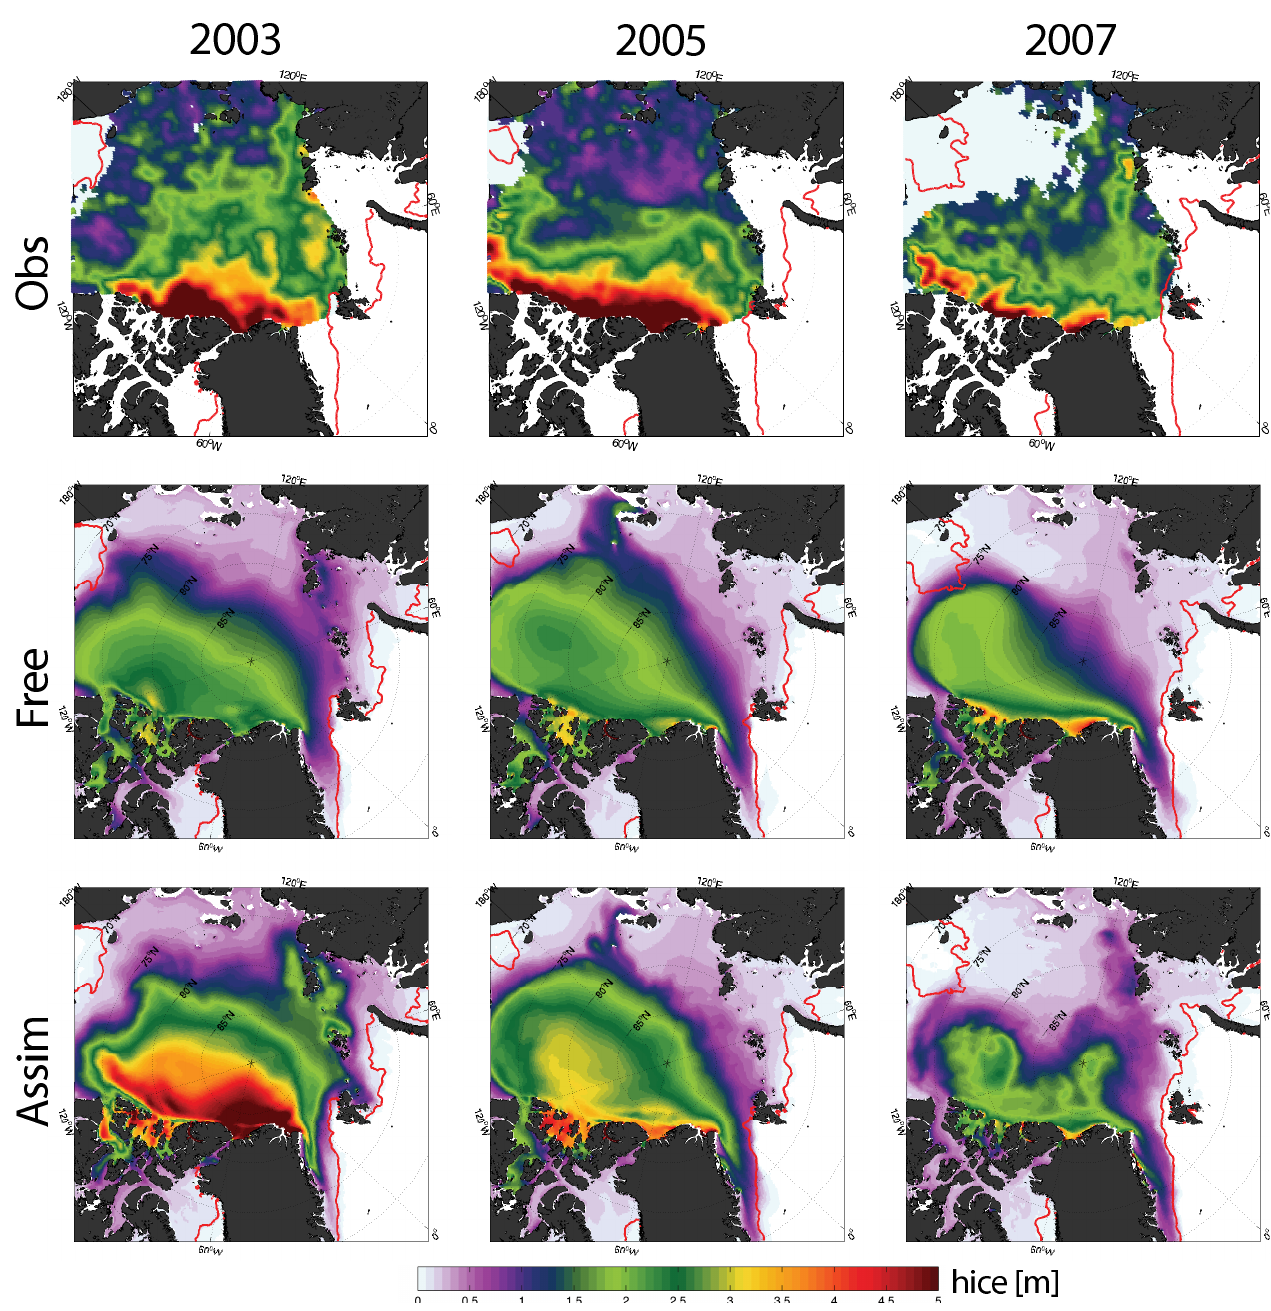
Fig. 13. Average fields for the ice thickness for October–November; for observations from ICESat (Kwok and Rothrock, 2009), free run and reanalysis. The red line shows the contour of 15% ICEC from AMSR